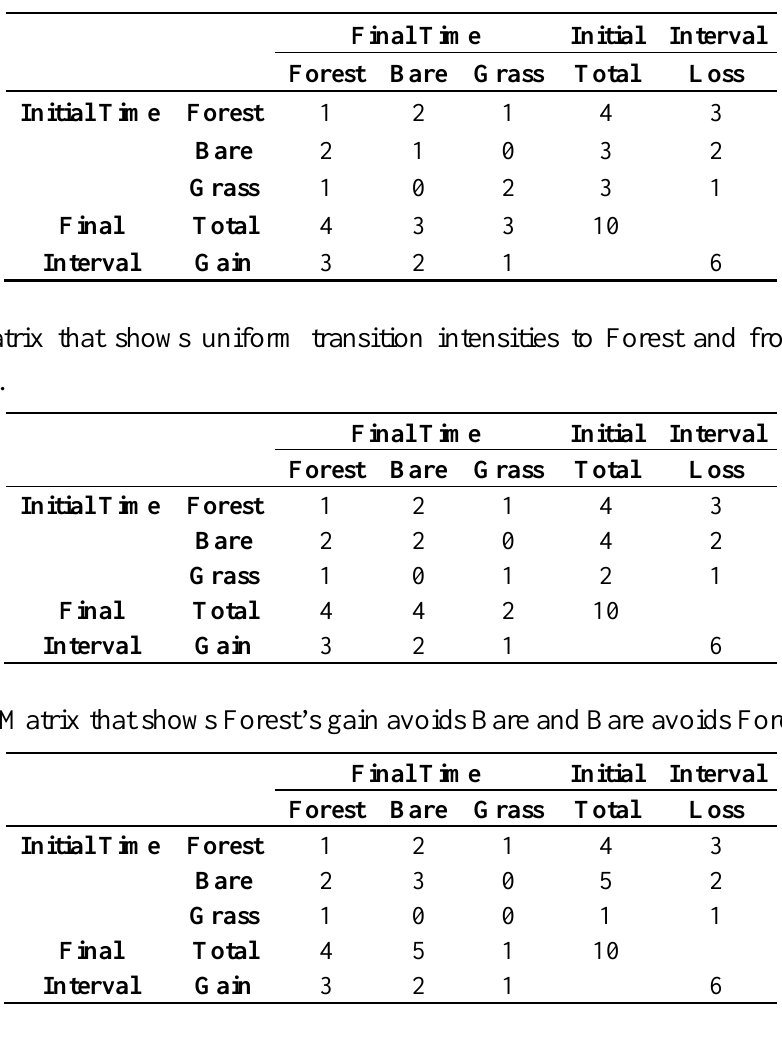
Table 3. Matrix that shows Forest’s gain targets Bare and Bare targets Forest’s loss.